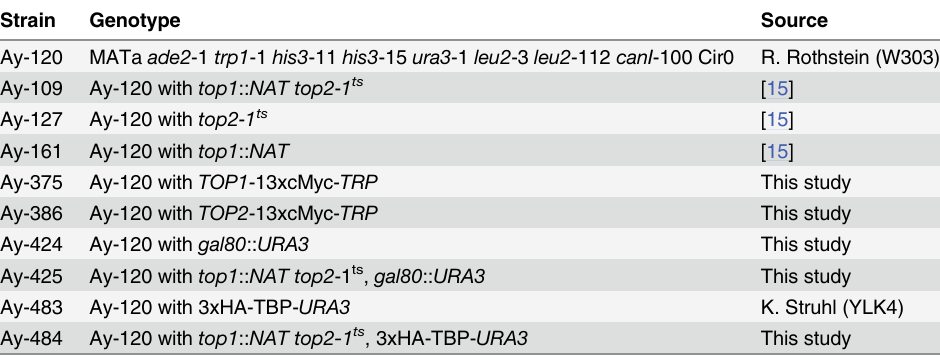
Table 1. S . cerevisiae strains used in this